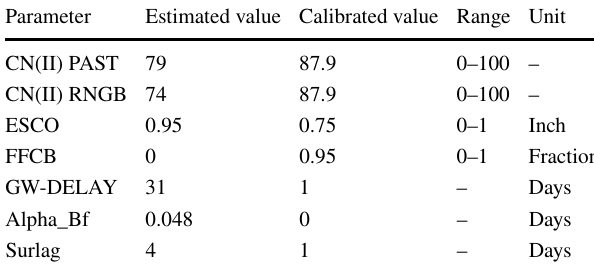
Fig. 10 Geological map for the study area (El-Naqa 2007)